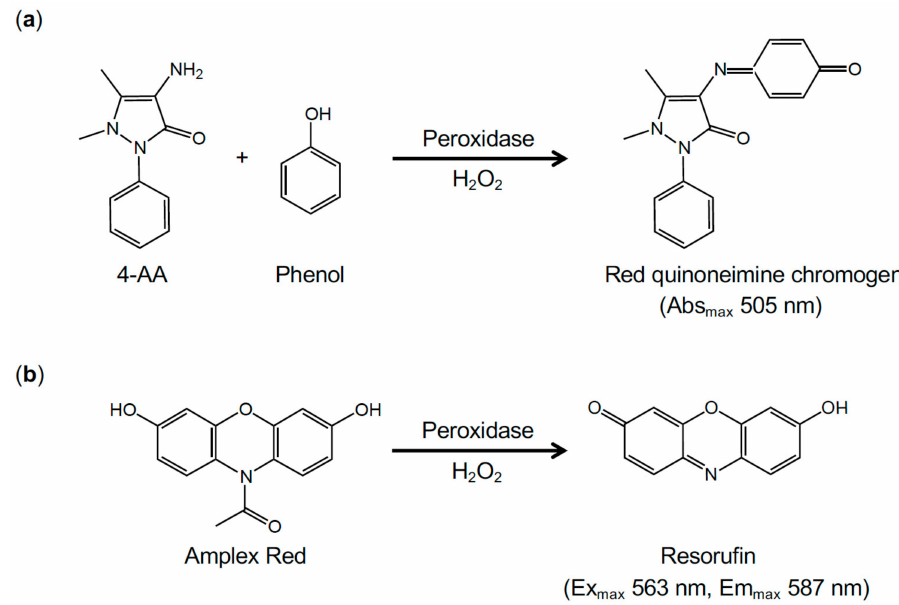
Figure 2. Detection of H 2 O 2 in enzymatic assays. ( a ) The oxidative coupling of phenol and 4-AA by H 2 O 2 in the presence of peroxidase produces a red quinoneimine chromogen (absorption maximum at 505 nm). ( b ) The oxidation of Amplex Red by H 2 O 2 in the presence of peroxidase produces highly fluorescent resorufin (excitation maximum at 563 nm and emission maximum at 587